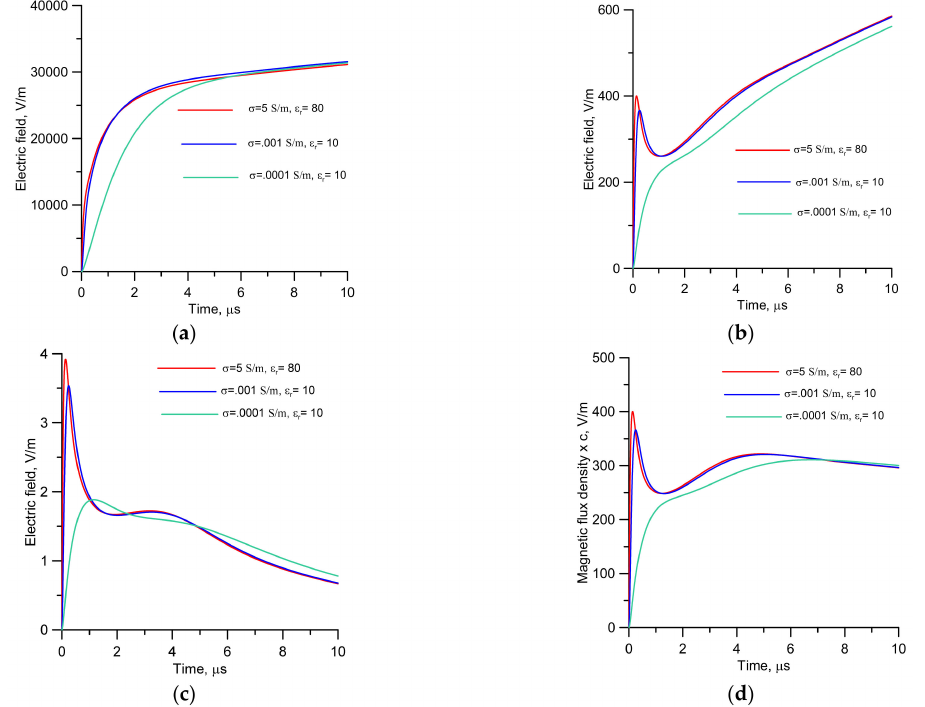
Figure 8. The source electric and magnetic fields generated by a subsequent return stroke of 12 kA for three sets of electric parameters at the strike point. ( a ) Electric field at 50 m, ( b ) electric field at 1 km, ( c ) electric field at 100 km, and ( d ) magnetic field at 1 km (note that the parameter depicted is the product of the magnetic field and the speed of light), but the fields are shown in an expanded time